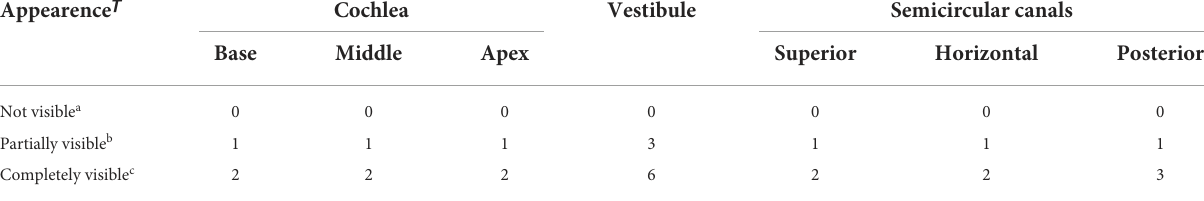
TABLE 1 Scoring criteria of IESAM in 3D-SPC-FLAIR images *